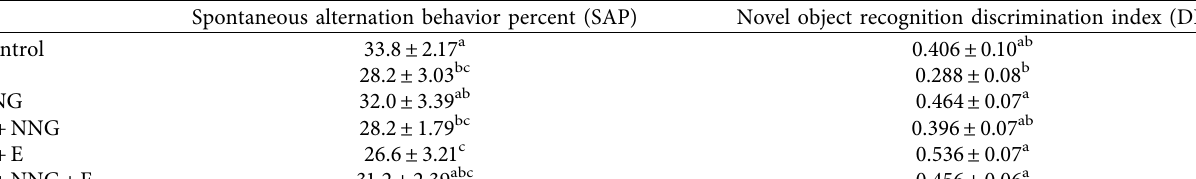
Table 2: Effect of treatments on learning and cognition of rats.